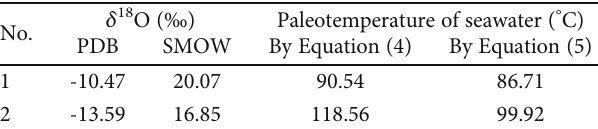
Table 2: Conversion of δ 18 O values under the PDB standard and SMOW standard and calculation results of paleoseawater